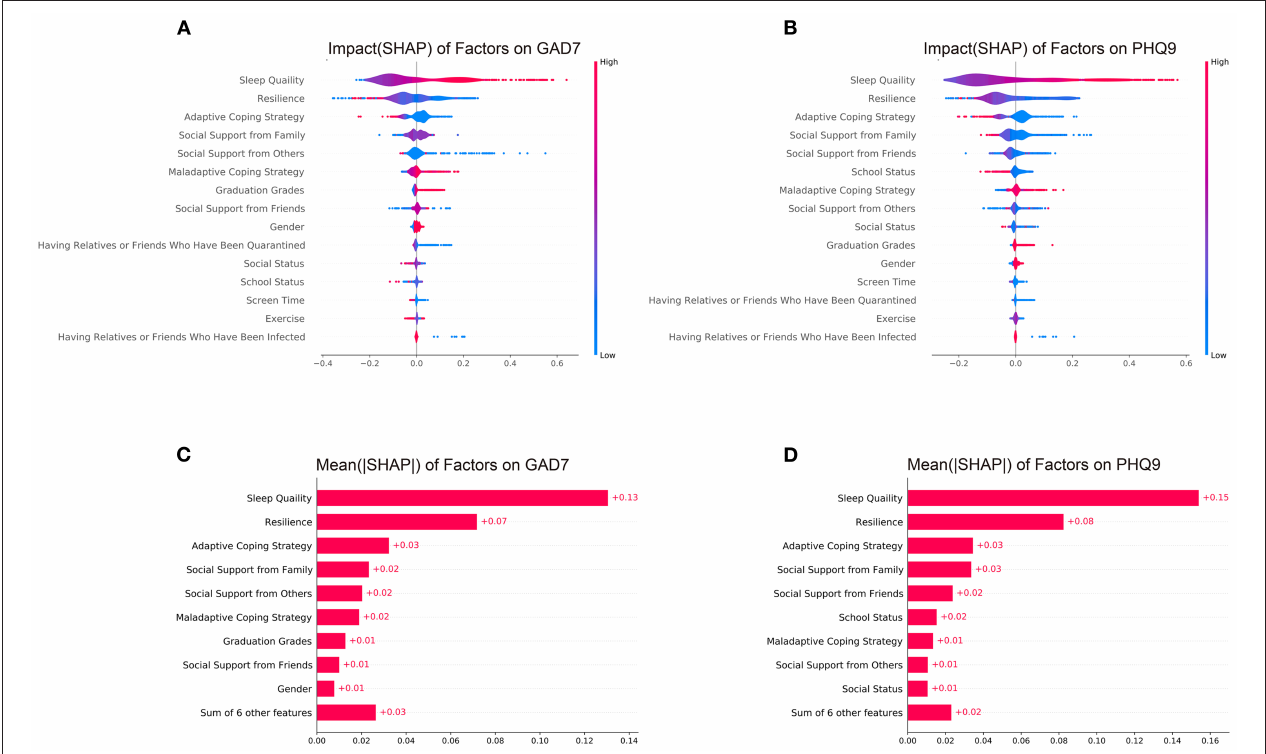
FIGURE 2 | SHAP (Shapley additive explanations value) of all features. (A) SHAP of factors for GAD-7; (B) SHAPs of factors for PHQ-9; (C) mean (|SHAP|) of factors for GAD-7; (D) mean (|SHAP|) of factors for PHQ-9. |SHAP| represents the absolute value of SHAP.